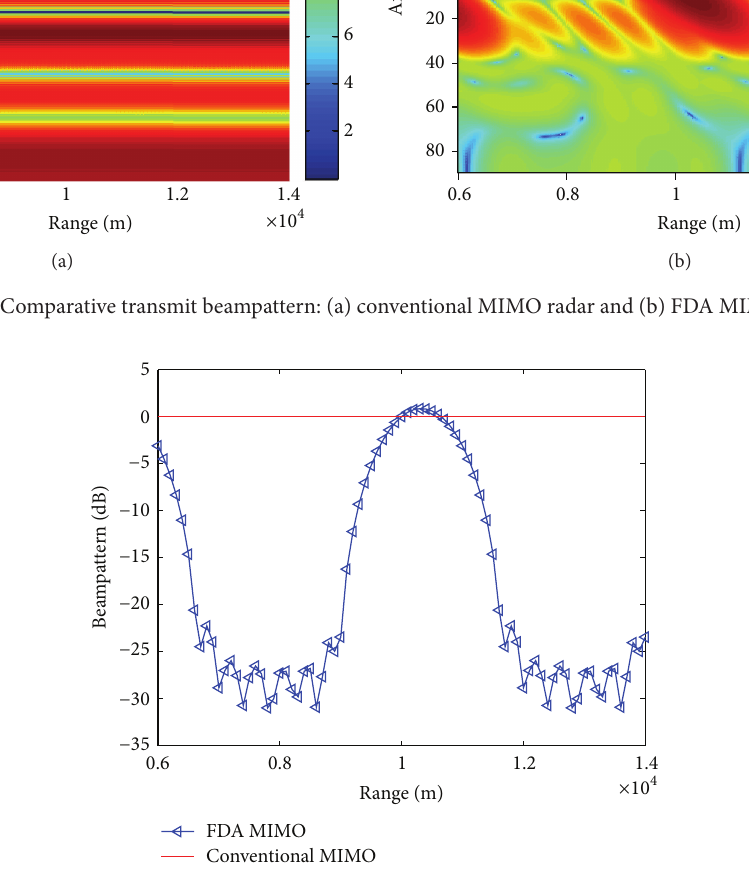
Figure 2: Comparative transmit beampattern in range profile 𝜃 = 10 ∘